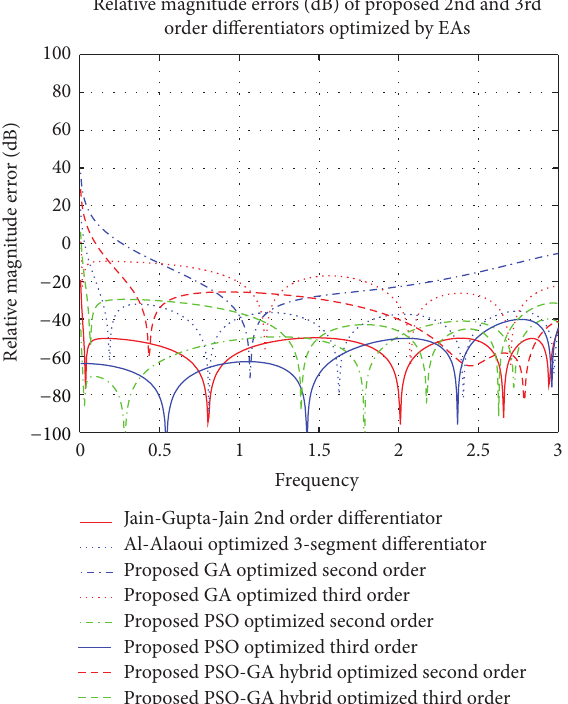
Figure 4: Comparison of relative magnitude errors (dB) of pro- posed optimized 2nd and 3rd order GA, PSO, and PSO-GA hybrid optimized digital differentiators with ideal and existing 2nd [32] and 3rd [1] order